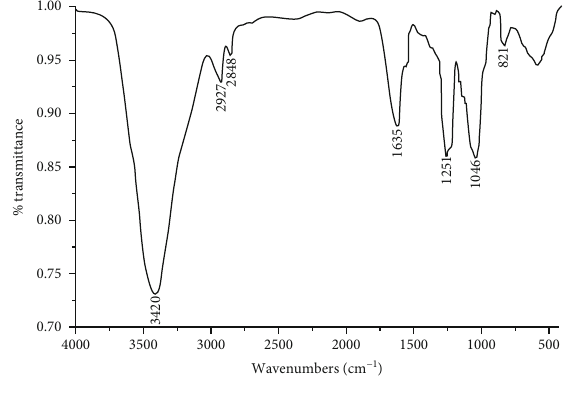
Figure 3: FT-IR spectrum of cSFP-C.